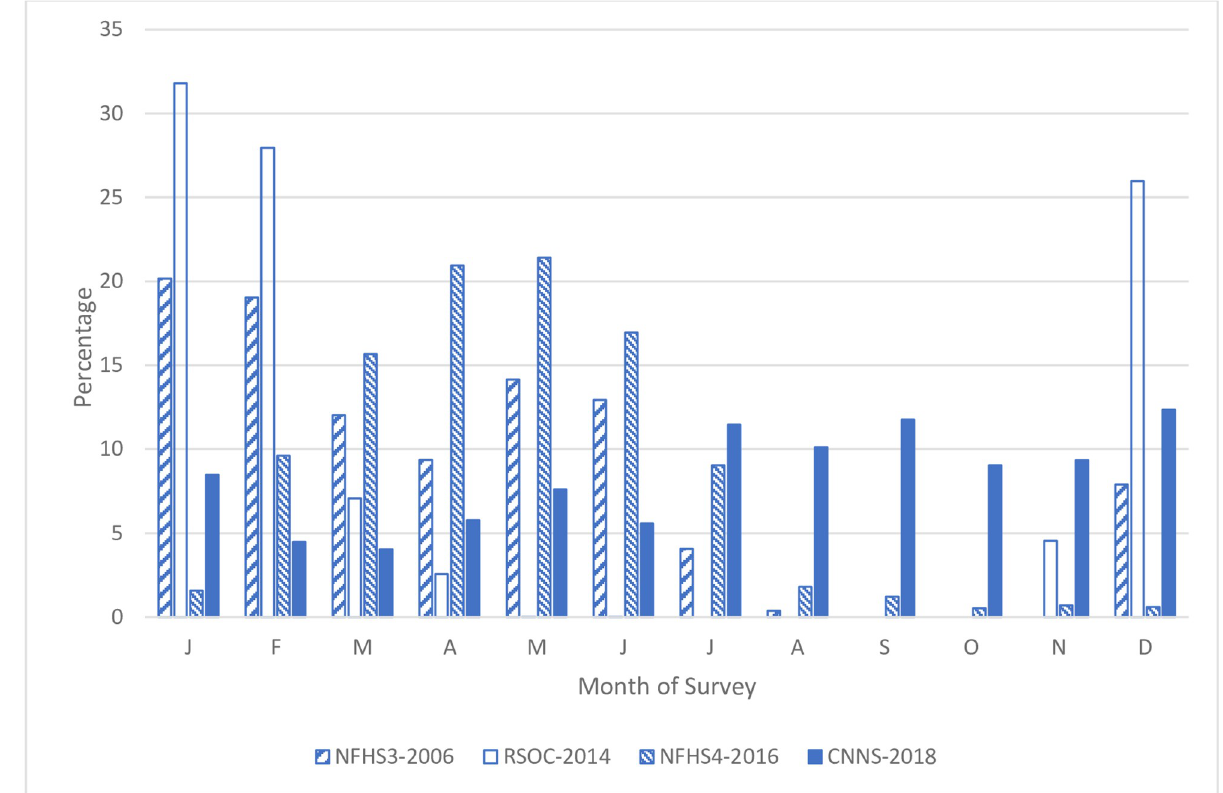
Fig 1. Distribution of month of data collection by NFHS-3, RSOC, NFHS-4 and CNNS.